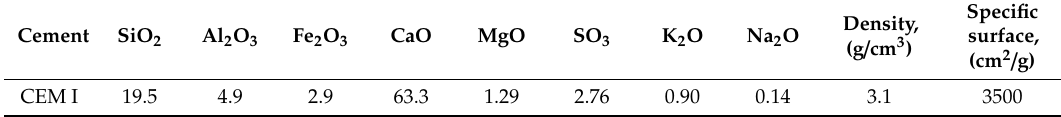
Table 4. Cement properties.